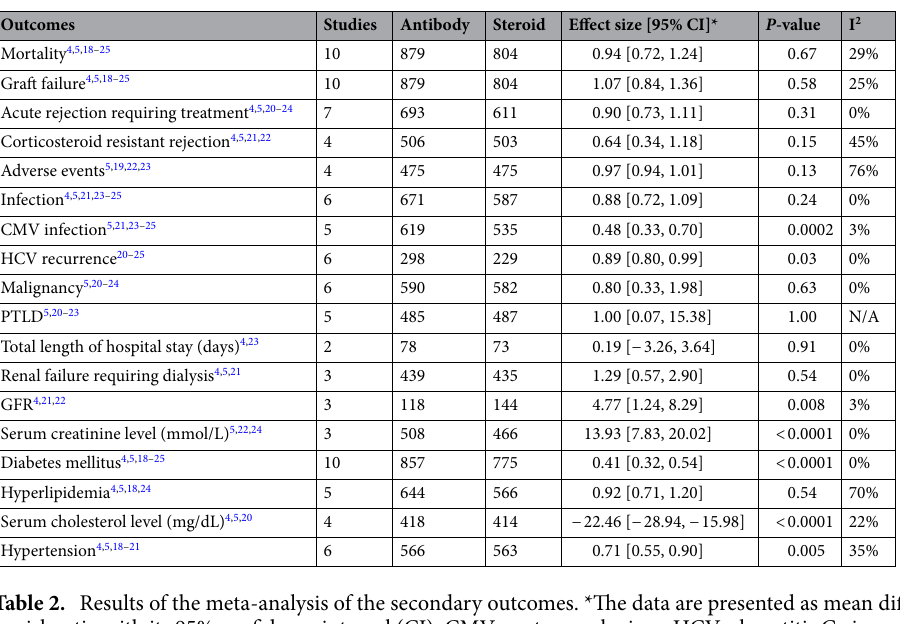
Table 2. Results of the meta-analysis of the secondary outcomes. *The data are presented as mean difference or risk ratio with its 95% confidence interval (CI). CMV = cytomegalovirus; HCV = hepatitis C virus; PTLD = post-transplant lymphoproliferative disorder; GFR = glomerular filtration rate; N/A = not available.